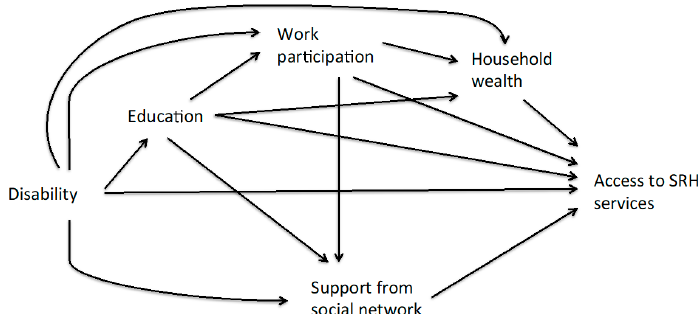
Figure 1. Conceptual model for direct and indirect pathways between disability and access to sexual and reproductive health (SRH) services.